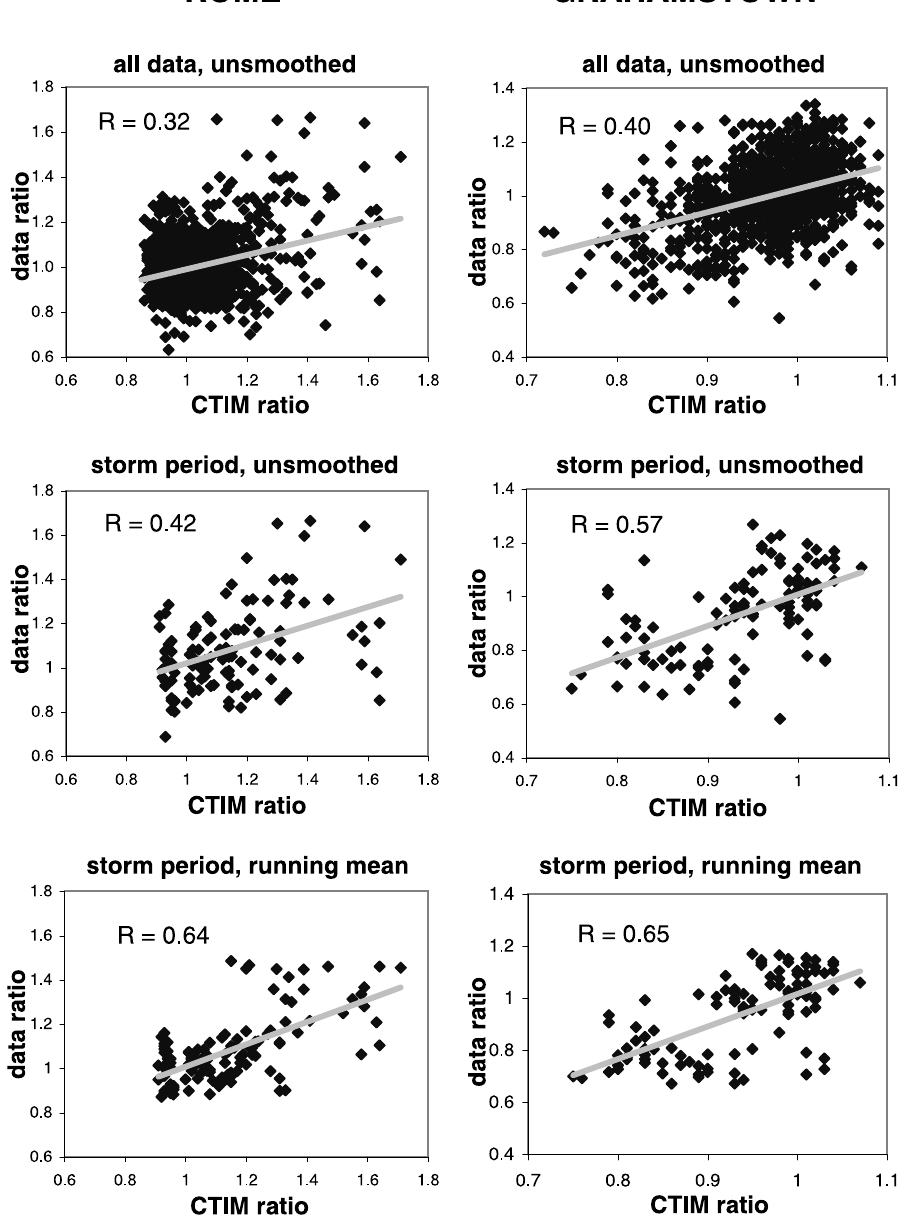
Fig. 8. Correlation of observed and predicted ratio of the dis- turbed to quiet foF2 , for Rome, on the left-hand side , and Gra- hamstown on the right .The model values are taken from the simula- tion with electric field variability. The top two panels show the correlation between the model and all the data over the 50-day interval, the middle panels show the relationship between during the first major storm interval (days 325 to 329), and the lower panels show the same storm in- terval but with the data smoothed using a five point